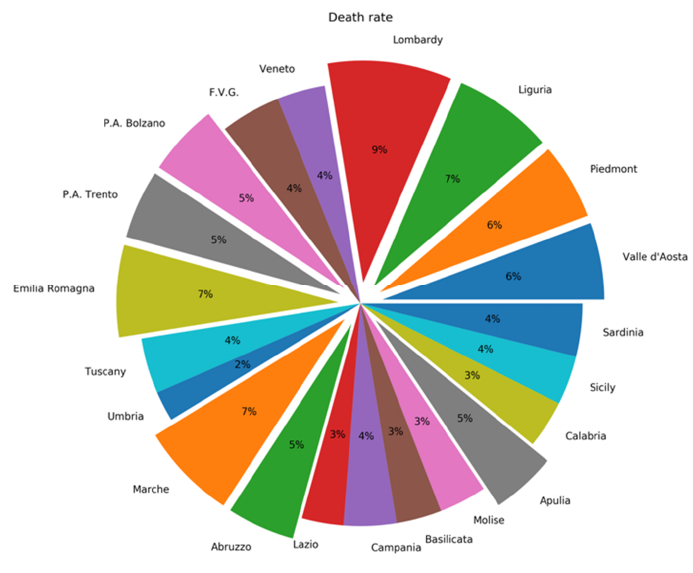
Figure 1. Death rate in Italy per region as of 23 April.